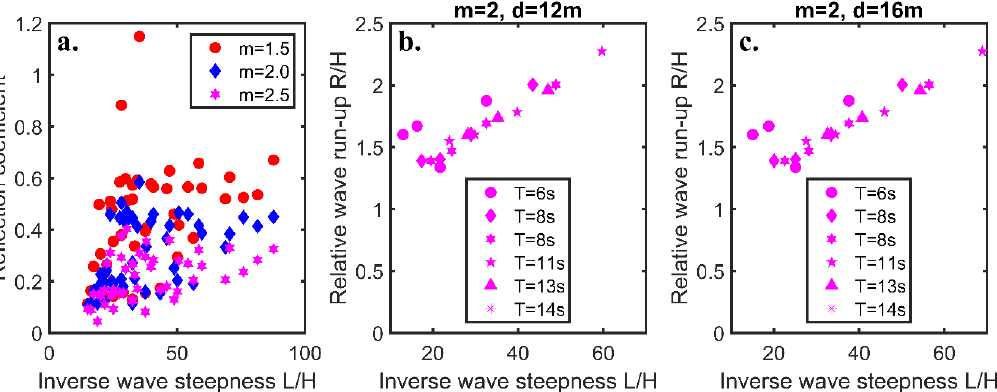
Figure 14. L/H versus reflection coefficient ( a ); L/H versus relative wave run-up ( b , c ) from numerical model results.